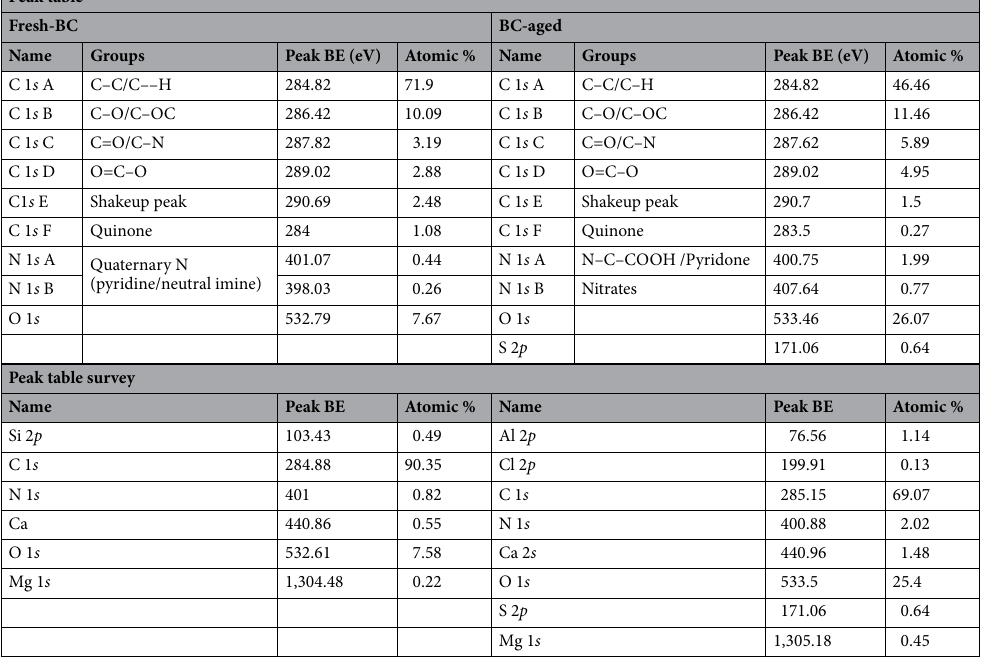
Table 2. Region and survey XPS analysis of crushed fresh and field aged biochar.